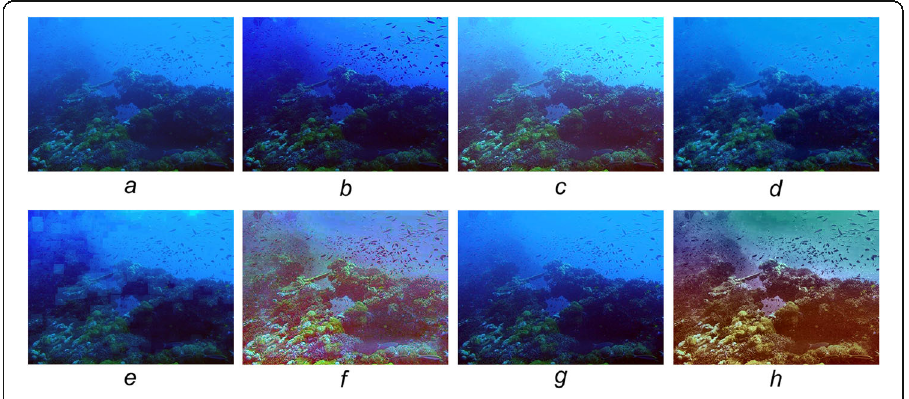
Fig. 8 Restoration results of the blue coral image. a Input image. b With UDCP. c With ICM. d With FVR.